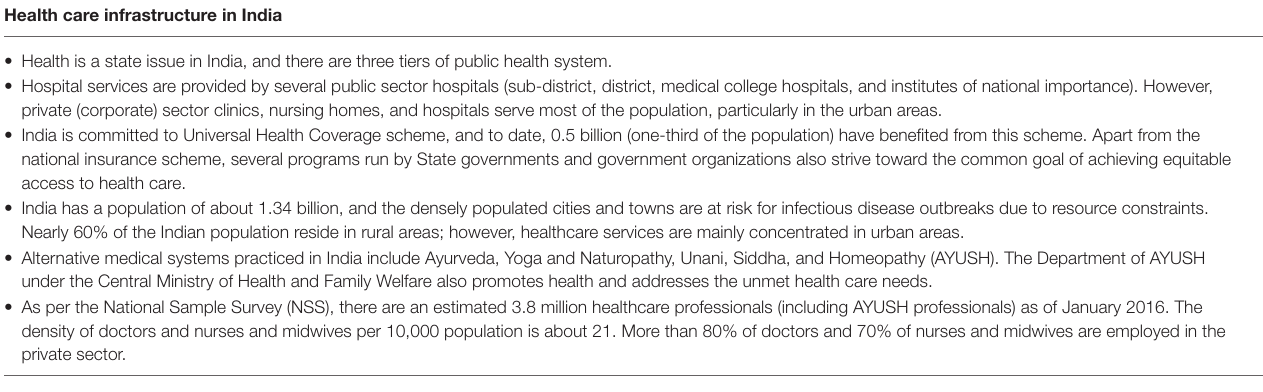
TABLE 1 | Brief overview of health care infrastructure in India and response to the COVID-19 pandemic. Health care infrastructure in